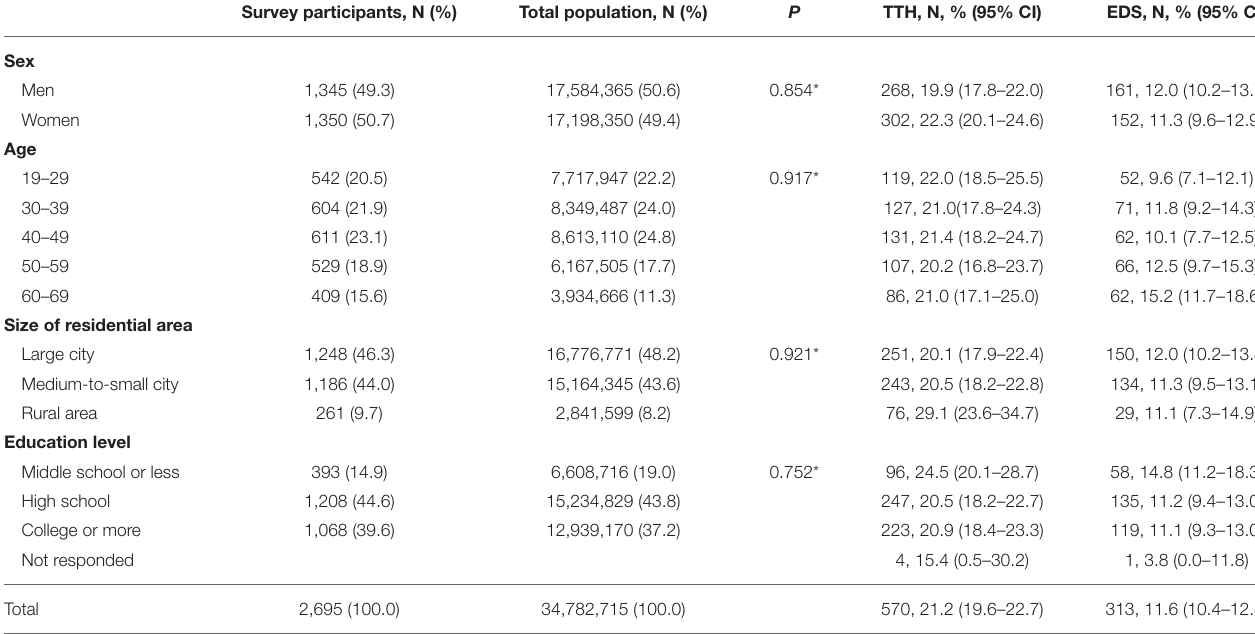
TABLE 1 | Demographic characteristics of the survey participants; total population; and participants with tension-type headache (TTH) and excessive daytime sleepiness (EDS). Survey participants, N (%) Total population, N (%) EDS, N, % (95% CI)